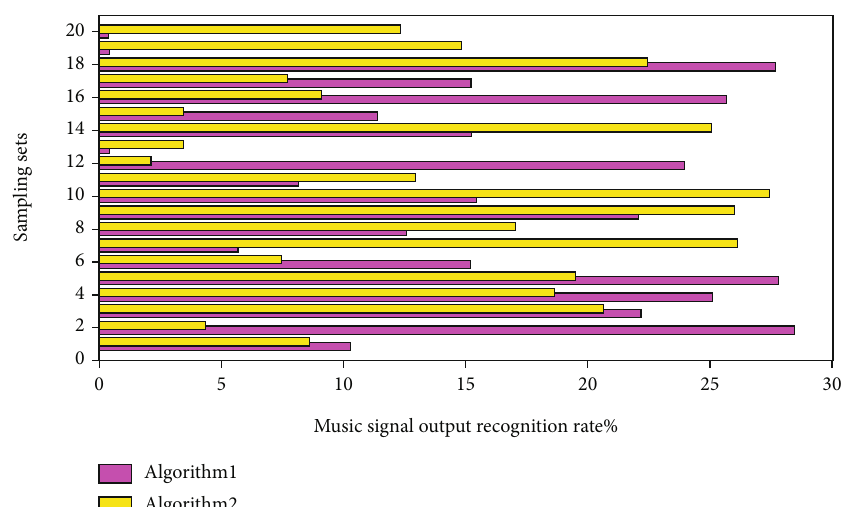
Figure 5: The histogram of music signal output recognition rate